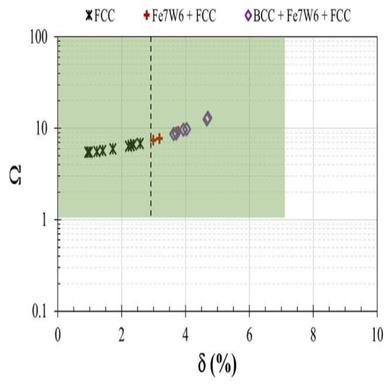
Various phases observed for Wx(CoCrFeMnNi)100−x associated with their respective W parameter and atomic size difference. The region identified by a green box corresponds to the range of Ω − δ values that are expected to form thermodynamically stable solid solutions. (For interpretation of the references to colour in this figure legend, the reader is referred to the web version of this article.)